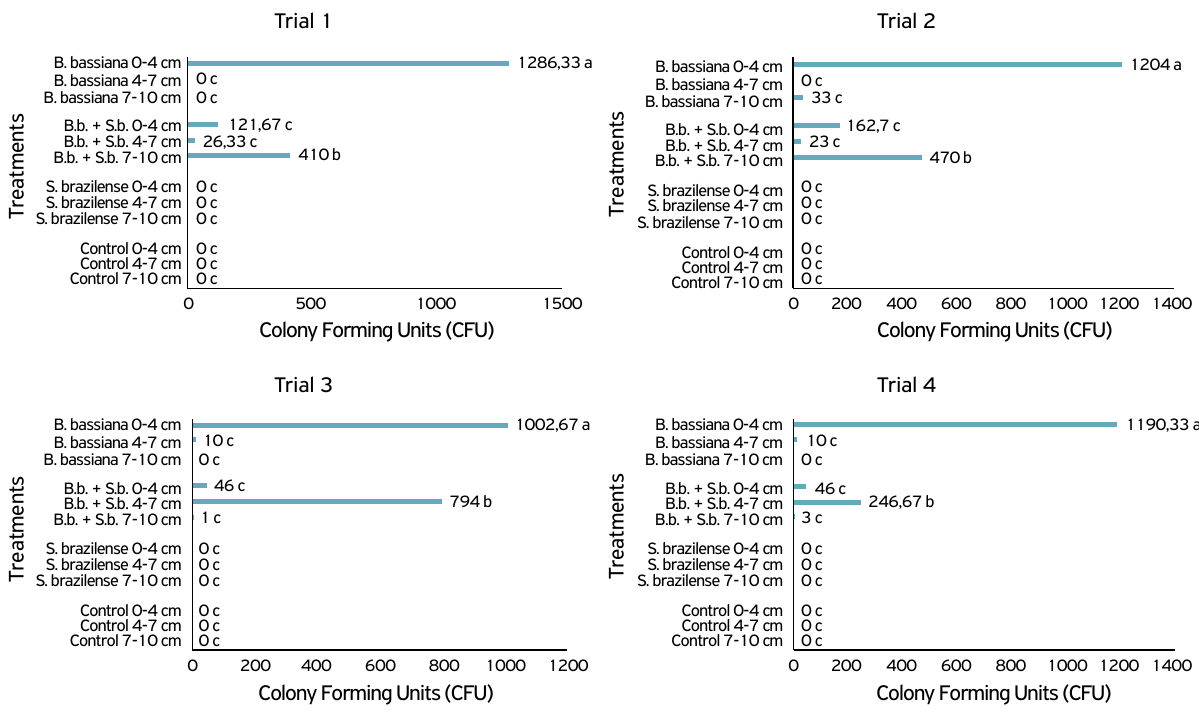
Figure 1. Conidia carriage trials in different depths of sandy soil after application of Beauveria bassiana , Steinernema brazilense , the combination of B. bassiana with S. brazilense (B.b. + S.b.), and control (water) in four repeated trials. Means followed by the same letter do not differ from each other by the Duncan test at 5%